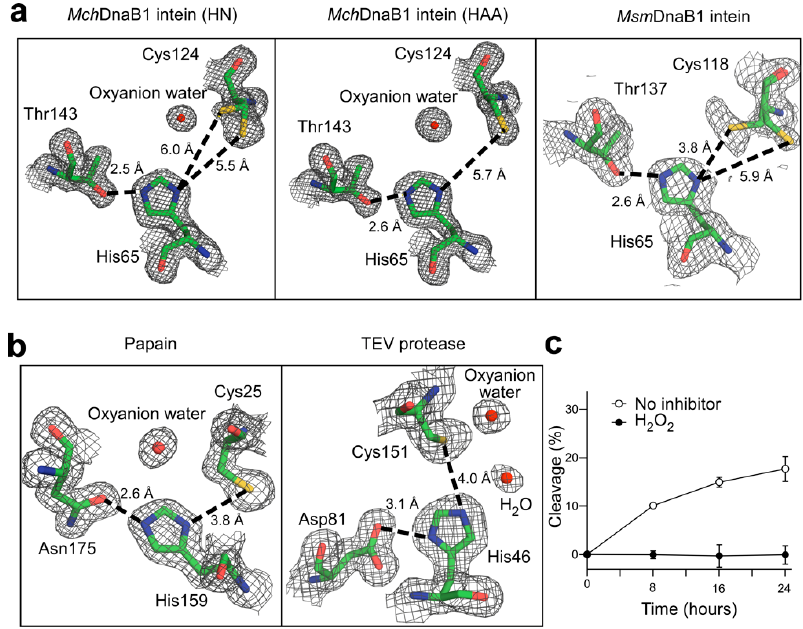
Figure 2. Comparison of the active sites. ( a ) Comparison of the electron density maps at 1 σ counter level around the catalytic-triad between the class 3 inteins: Mch DnaB1_HN (6rix, chain B), Mch DnaB1_HAA (6riy, chain A), and Msm DnaB1 inteins (6bs8, chain B) [21]. Oxyanion waters are modeled for the large electron density near Cys124. Dashed lines indicate distances between O γ of Thr and N ε of His and between S γ of Cys and N δ of His. When two conformations for Cys were modelled, we showed both distances. ( b ) The electron density maps of the catalytic triad from papain (1ppn) and TEV protease (1lvm, chain A). The catalytic triads are depicted together with the electron density maps at 1.1 sigma counter level. Dashed lines indicate the shorter distances between O δ of Asn or Asp and site-chain N atoms of His and between S γ of Cys and side-chain N atoms of His. ( c ) Inhibition of the N-cleavage of Mch DnaB1_HN by H 2 O 2 . The data were averaged from three replicates. Error bars represent one standard deviation.